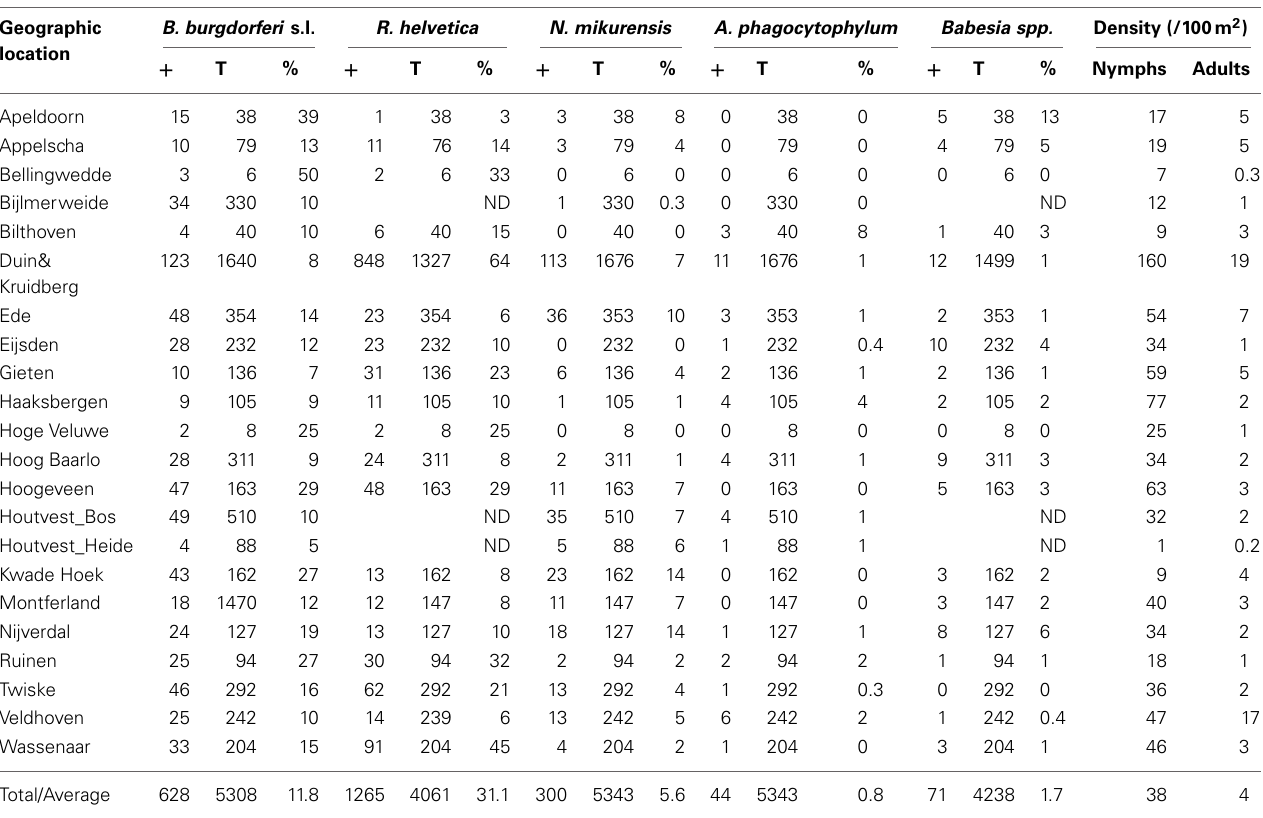
Table 2 | Prevalence (%) of the five major pathogens found in the 22 study areas. Geographic